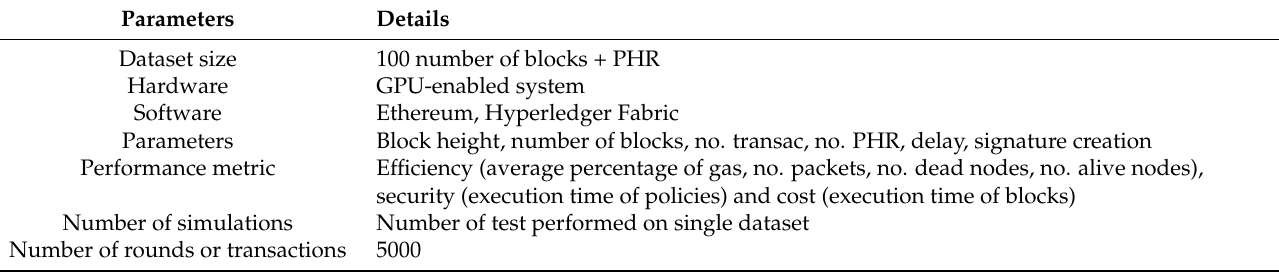
Table 2. Simulation setup, configurations, and